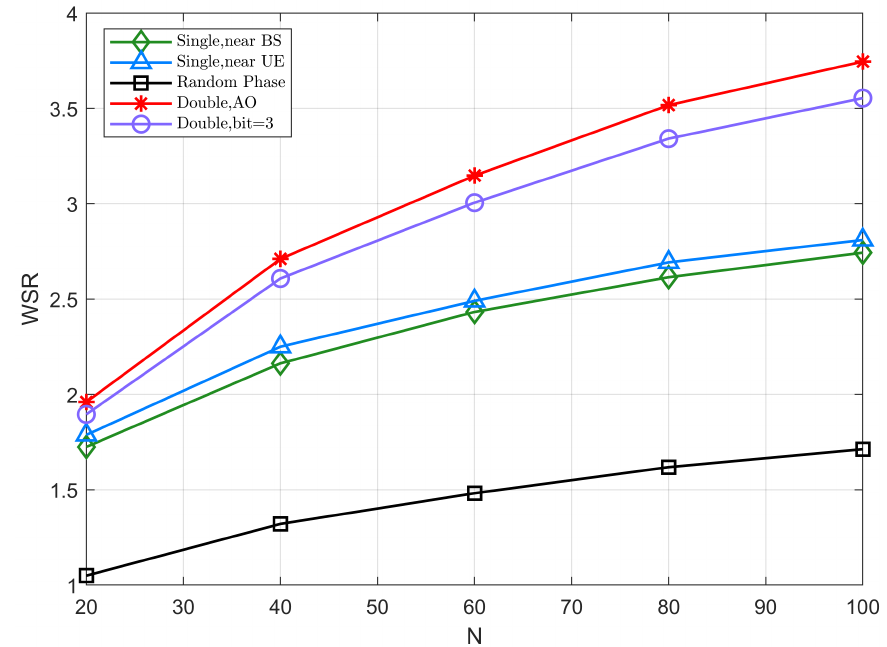
Figure 6. The WSR versus the total number of the reflection elements N.